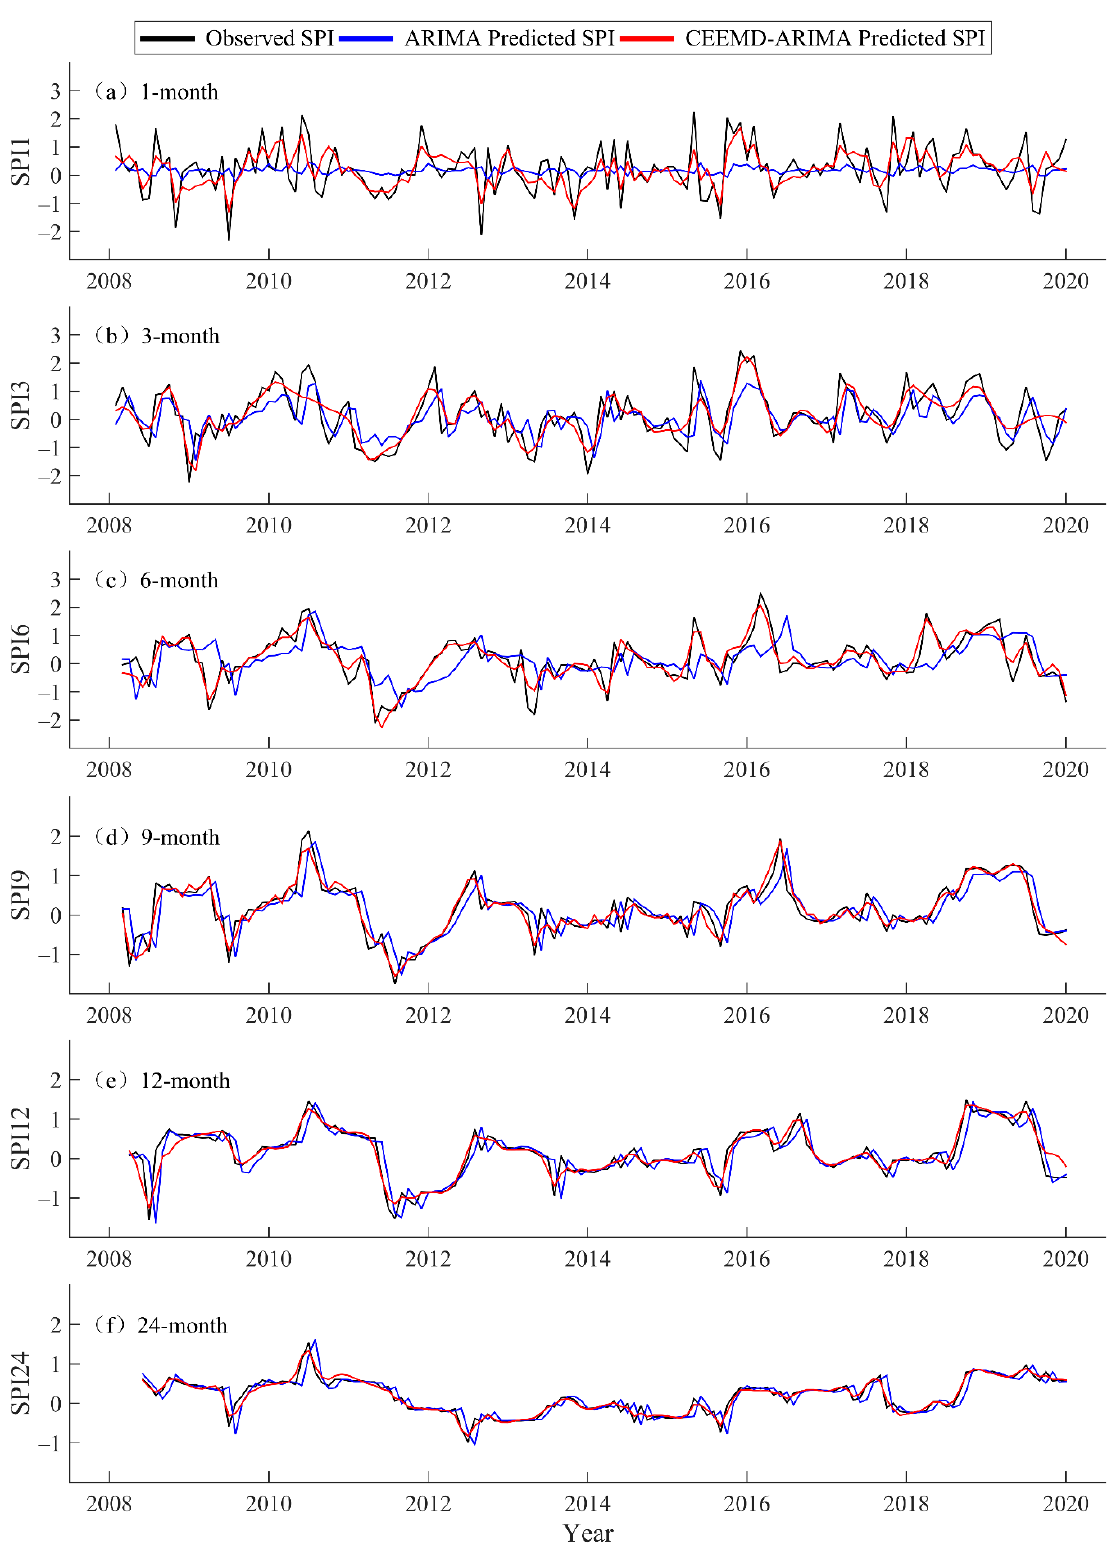
Figure 5. Comparison of the predicted and observed values of the SPIs on the 1-month ( a ), 3-month ( b ), 6-month ( c ), 9-month ( d ), 12-month ( e ), and 24-month ( f ) time scales of the ARIMA model and the CEEMD–ARIMA model at Huinong Station (2008–2019).